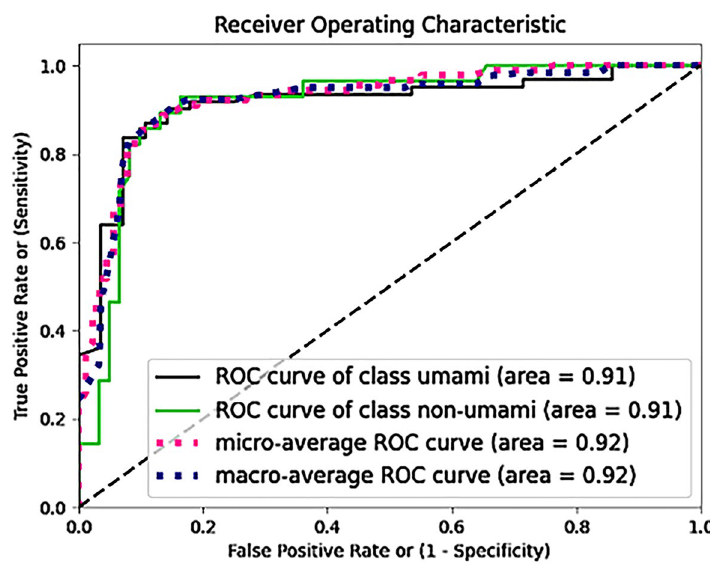
Figure 2. Receiver operating characteristic curve of the umami versus non-umami